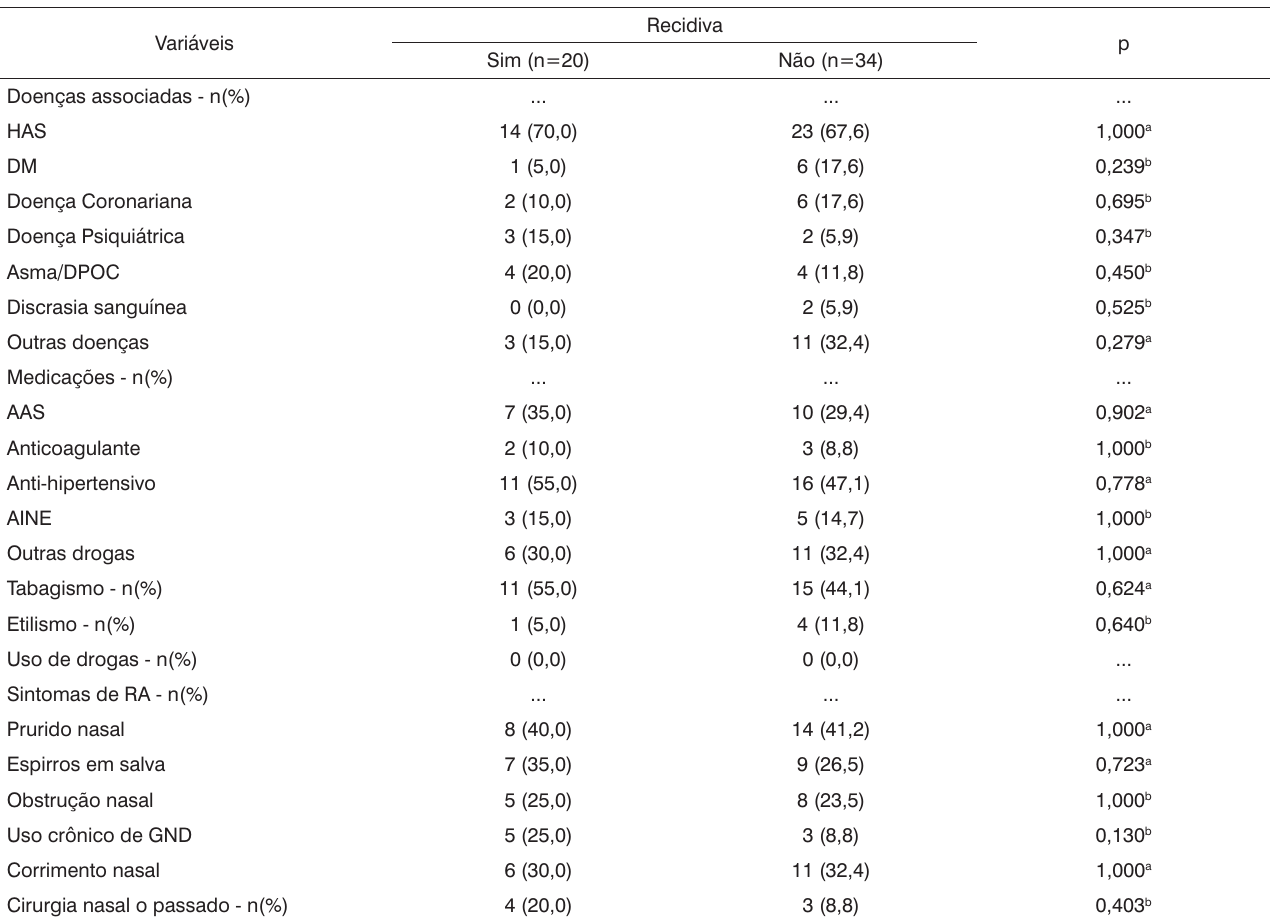
Tabela 4. Caracterização da amostra conforme recidiva